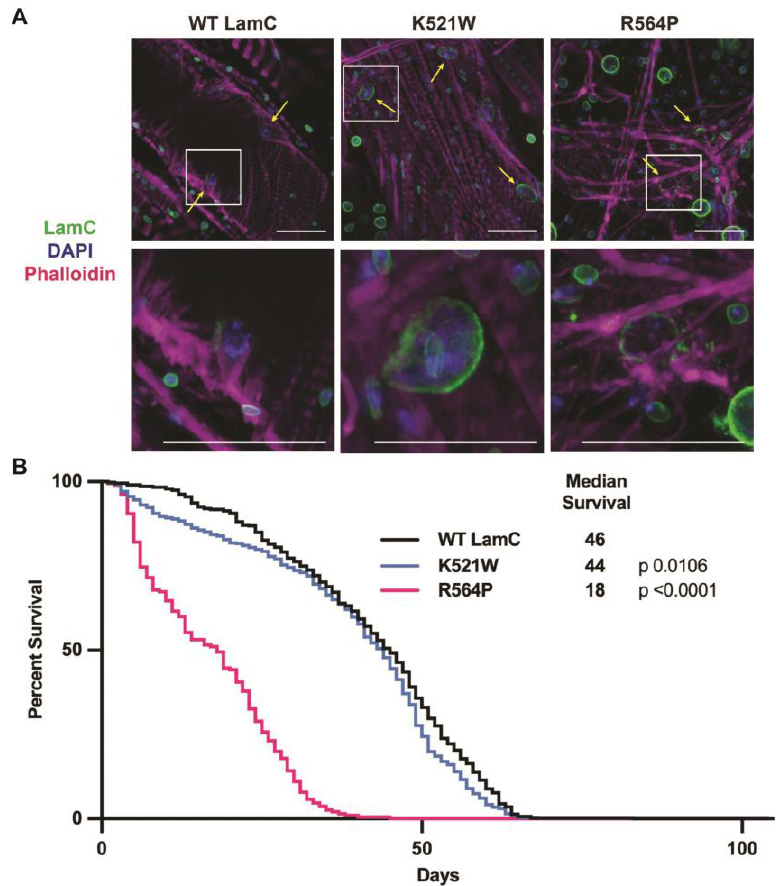
Figure 7. Cardiac-specific expression of LamC R564P, but not LamC K521W, reduces adult lifespan. ( A ) Drosophila hearts expressing either wild-type or mutant LamC were stained with phalloidin (magenta), DAPI (blue), and antibodies to LamC (green). The yellow arrows indicate cardiomyocytes. The scale bar represents 30 µ m. ( B ) Adult longevity was determined for flies expressing either wild-type or mutant LamC in the heart. The graph shows the percent of living adults per day, which were maintained in fresh vials. The median survival time and the statistical analysis using the Man- tel–Cox test was calculated using GraphPad Prism version 9.5.0, GraphPad Software, San Diego, CA, USA.